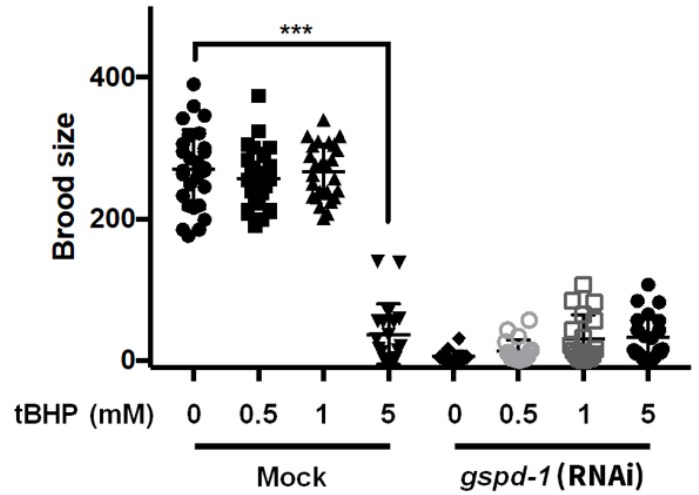
Figure 2. Effect of short-term tBHP administration on brood size. Brood size of mock and gspd-1 - knockdown C. elegans with or without tBHP administration (0.5, 1 and 5 mM) (*** p < 0.001).